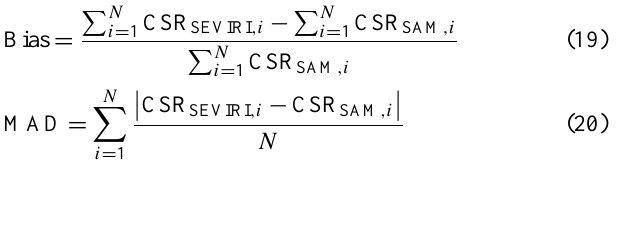
Fig. 11. Exemplary excerpt of the circumsolar ratio (CSR) time series used for the validation. In total 107 data pairs are shown. Grey symbols indicate that water clouds were identified in the manual screening of sky camera images. Time is given as UTC.